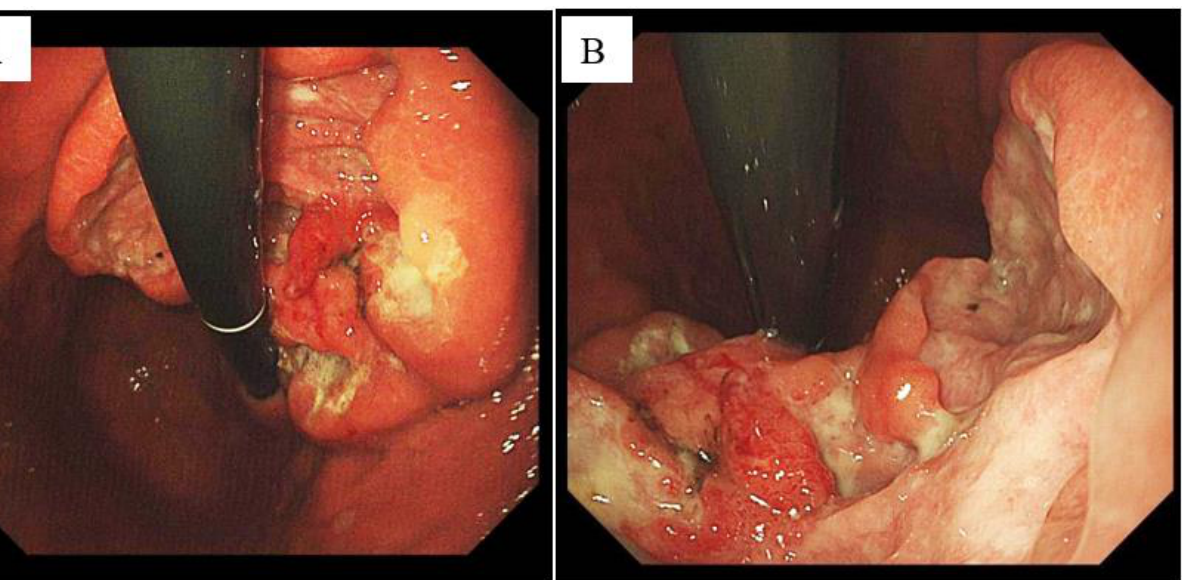
Figure 1. The patient’s gastroscopic results before admission. The stomach can be seen in the populous lesions of the volcanic mouths ( A ). It can be seen that the bottom is uneven and there is pus ( B ). Endoscopy is important for the diagnosis of GIST. It shows that non-specific smooth processes cover the normal mucosa, with ulceration, necrosis, and bleeding features. It can be seen from the gastroscopy that the mucosal folds are at the backbone, which are orange red, there is a small bend in the middle of the middle, and the back walls have huge placement lesions. The bottom of the bottom is a selfie, the surrounding embankment bulges, and the biopsy is tough. GIST is the most common source of tissue from the digestive tract, accounting for